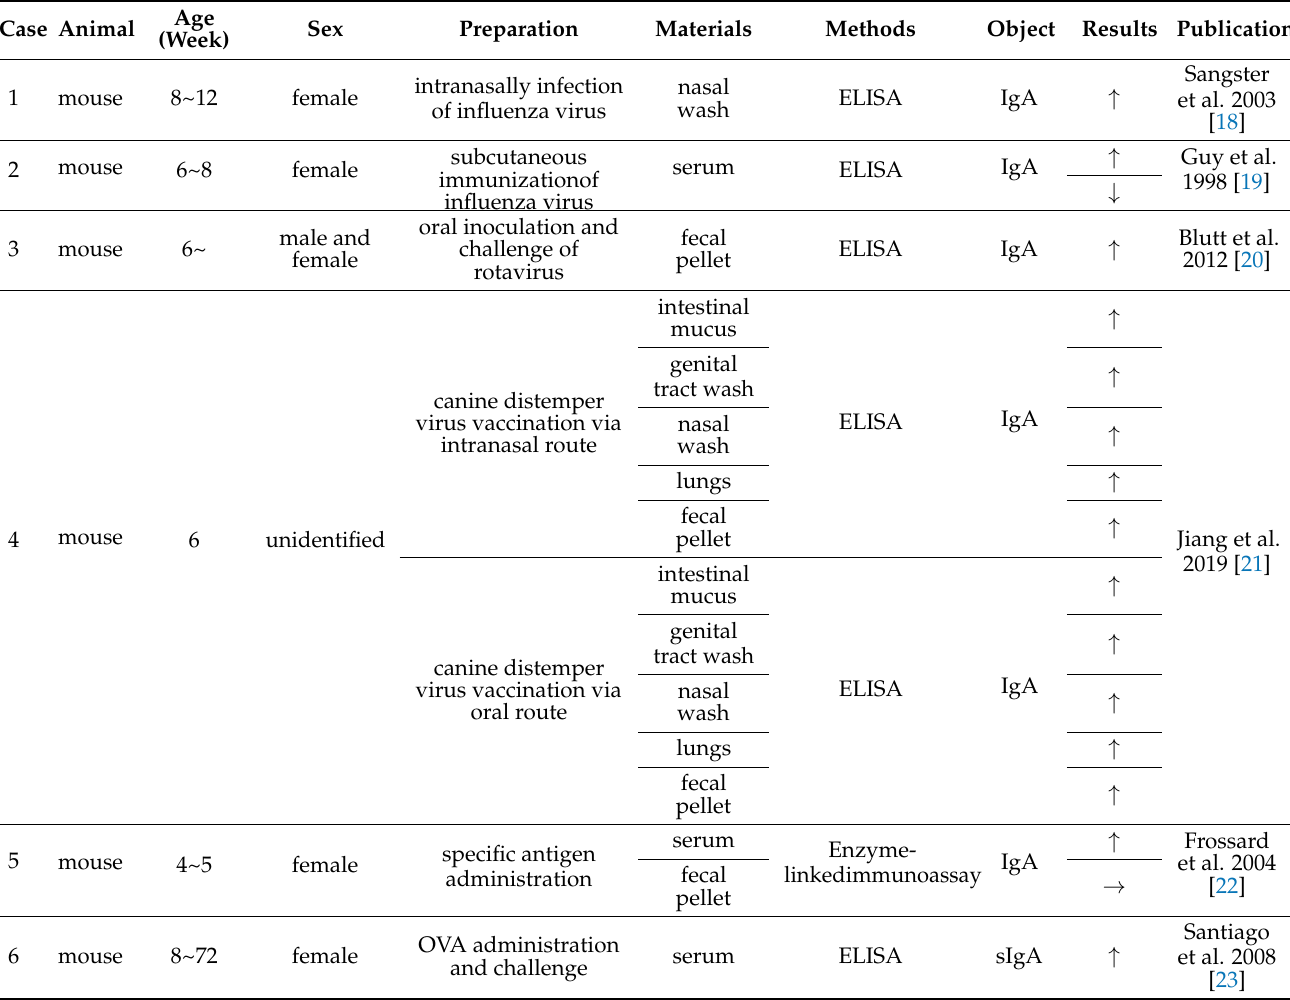
Table 6. Review of the international literature on cases of animal experiments involving IgA